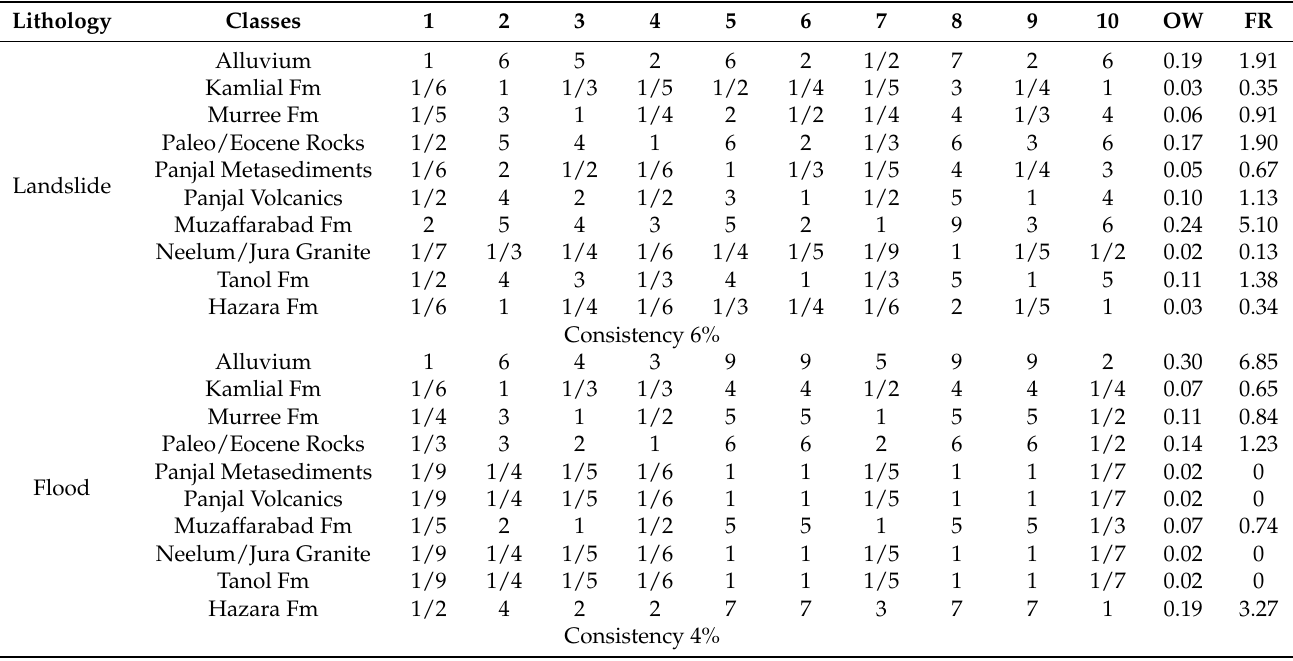
Figure 9. Lithology causative factor map. Table 10. AHP matrices and OWs for the lithology causative factor